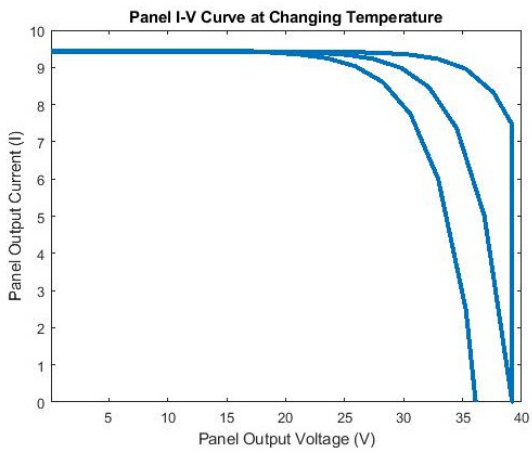
Figure 6. I-V characteristic under changing